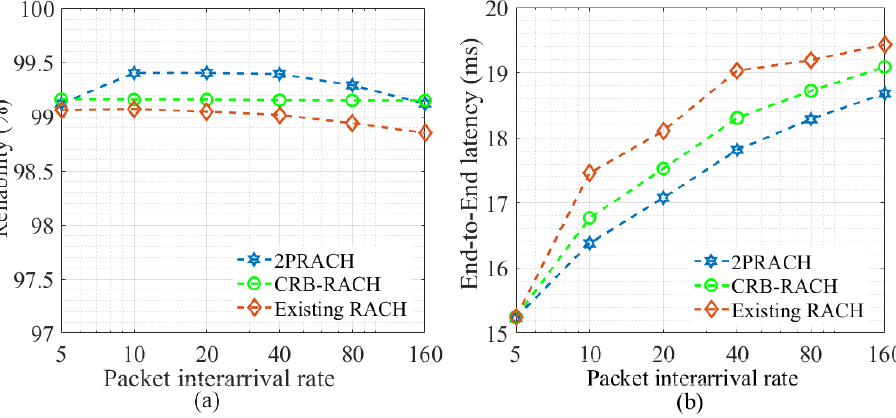
Figure 6. Performance comparison of 2PRACH with existing RACH and CRB-RACH procedures with varying packet interarrival rate, where ( a ) network reliability (%), and ( b ) end-to-end latency